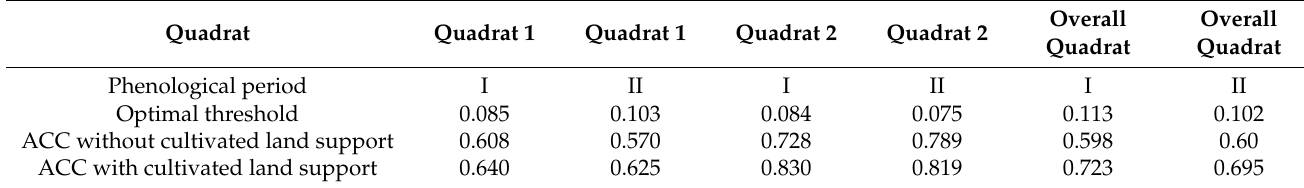
Table 8. Extraction results from cultivated land support of the first two phenological periods.